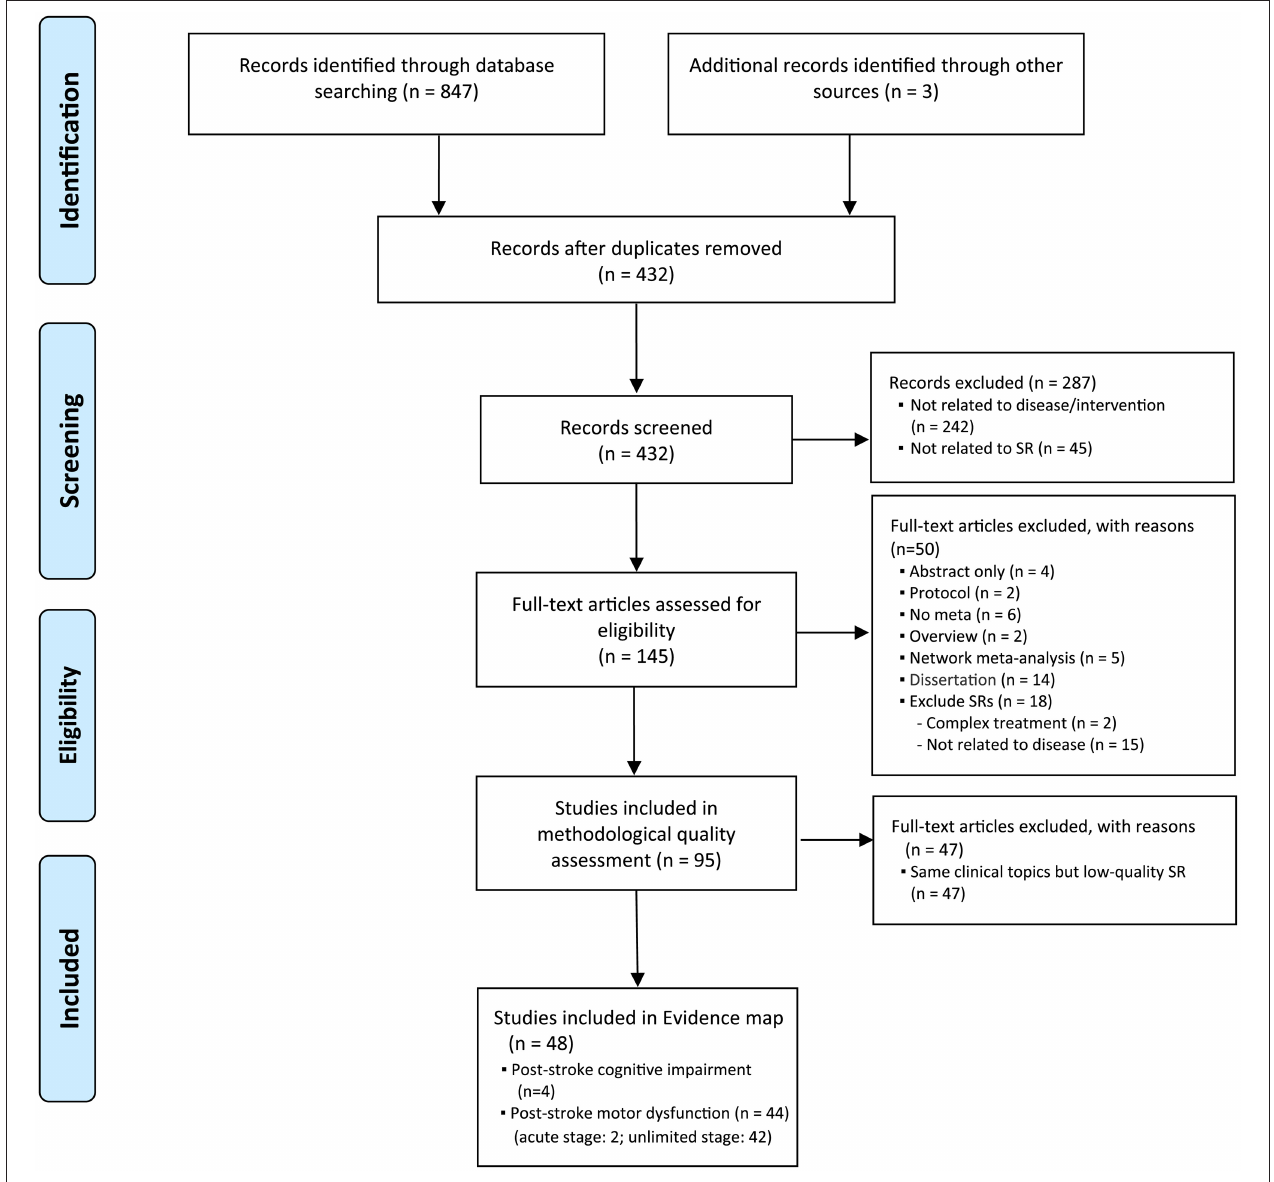
FIGURE 1 | Study flow diagram. SR, systematic